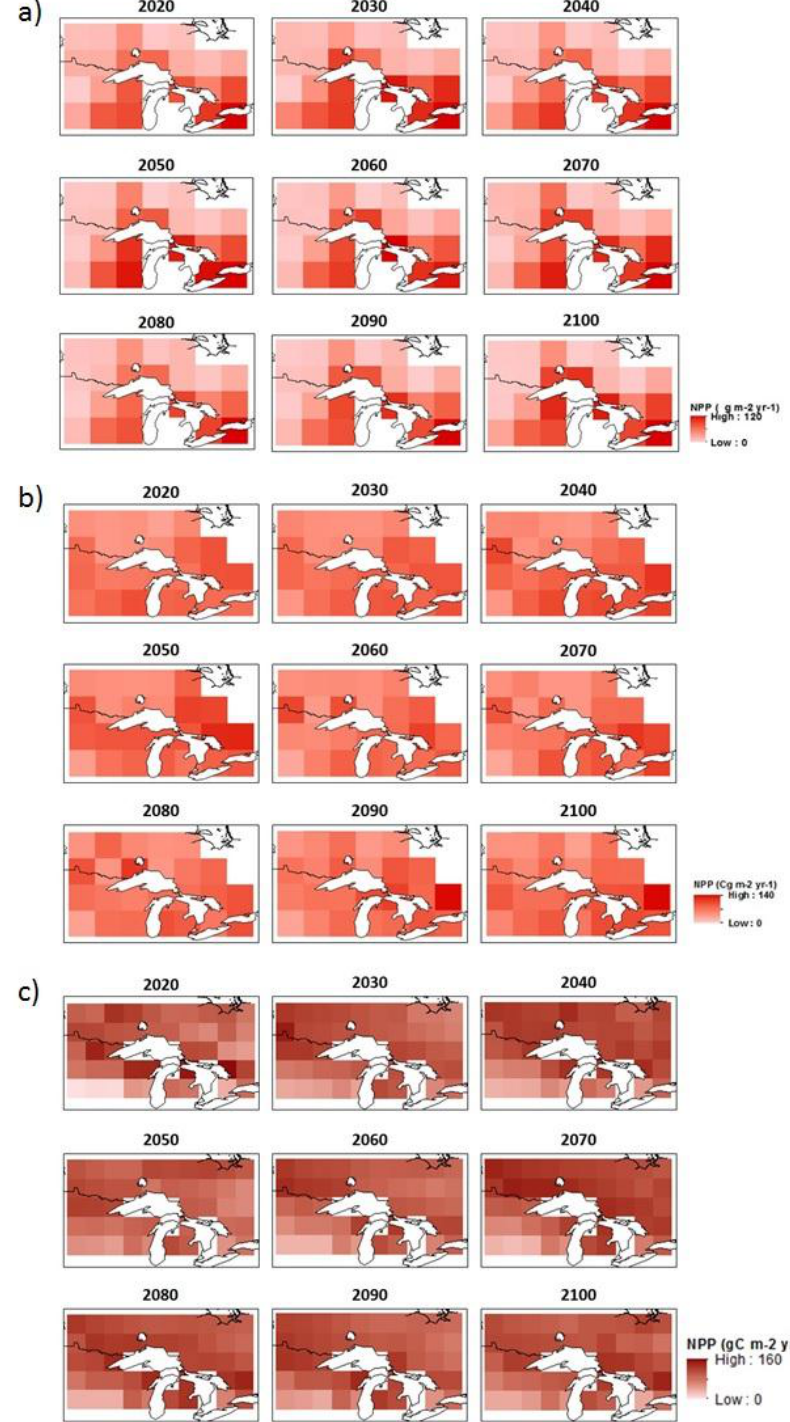
Figure 3. Spatial distribution of projections of annual Net Primary Production (NPP) over time as simulated by the Global Climate Models: ( a ) CanESM2; ( b ) MIROC; and ( c )